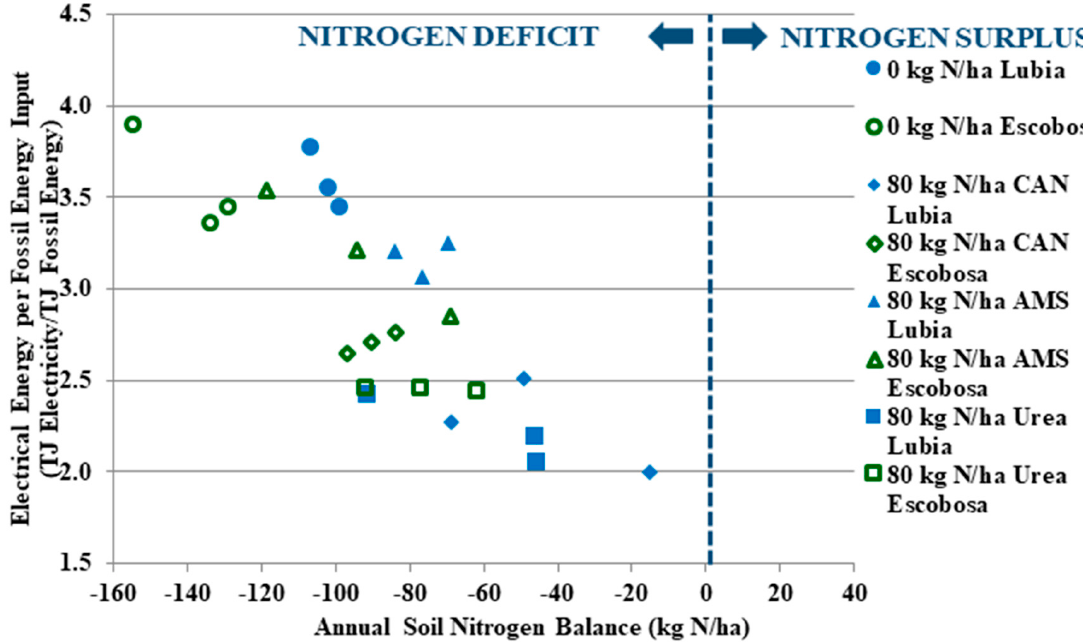
Figure 5. Relationship between the electrical energy produced per fossil energy consumed as a function of the soil nitrogen balance obtained for the rye energy crops grown under different fertilizer regimes. CAN: calcium ammonium nitrate, AMS: ammonium sulphate. Regression equation: y = − 0.0145x + 1.6511.